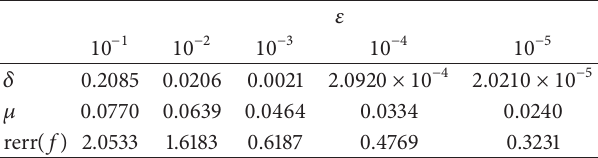
Table 4: 𝛿 , 𝜇 and the relative error rerr( 𝑓 ) with 𝑘 = 2 , 𝑝 = 5 and 𝜇 = (𝛿/𝐸) 1/7 for different 𝜀